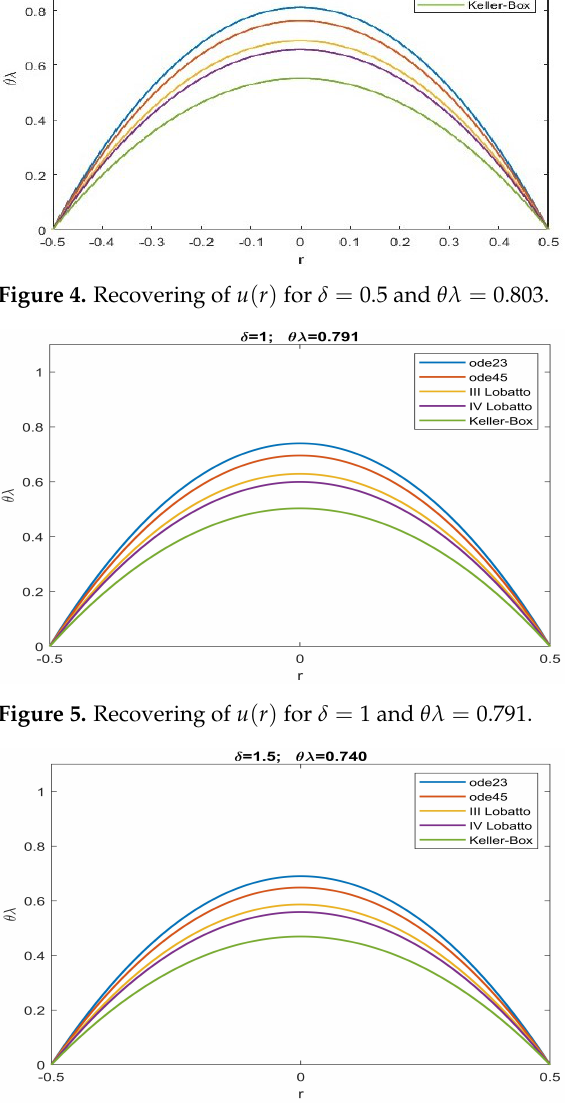
Figure 6. Recovering of u ( r ) for δ = 1.5 and θλ =